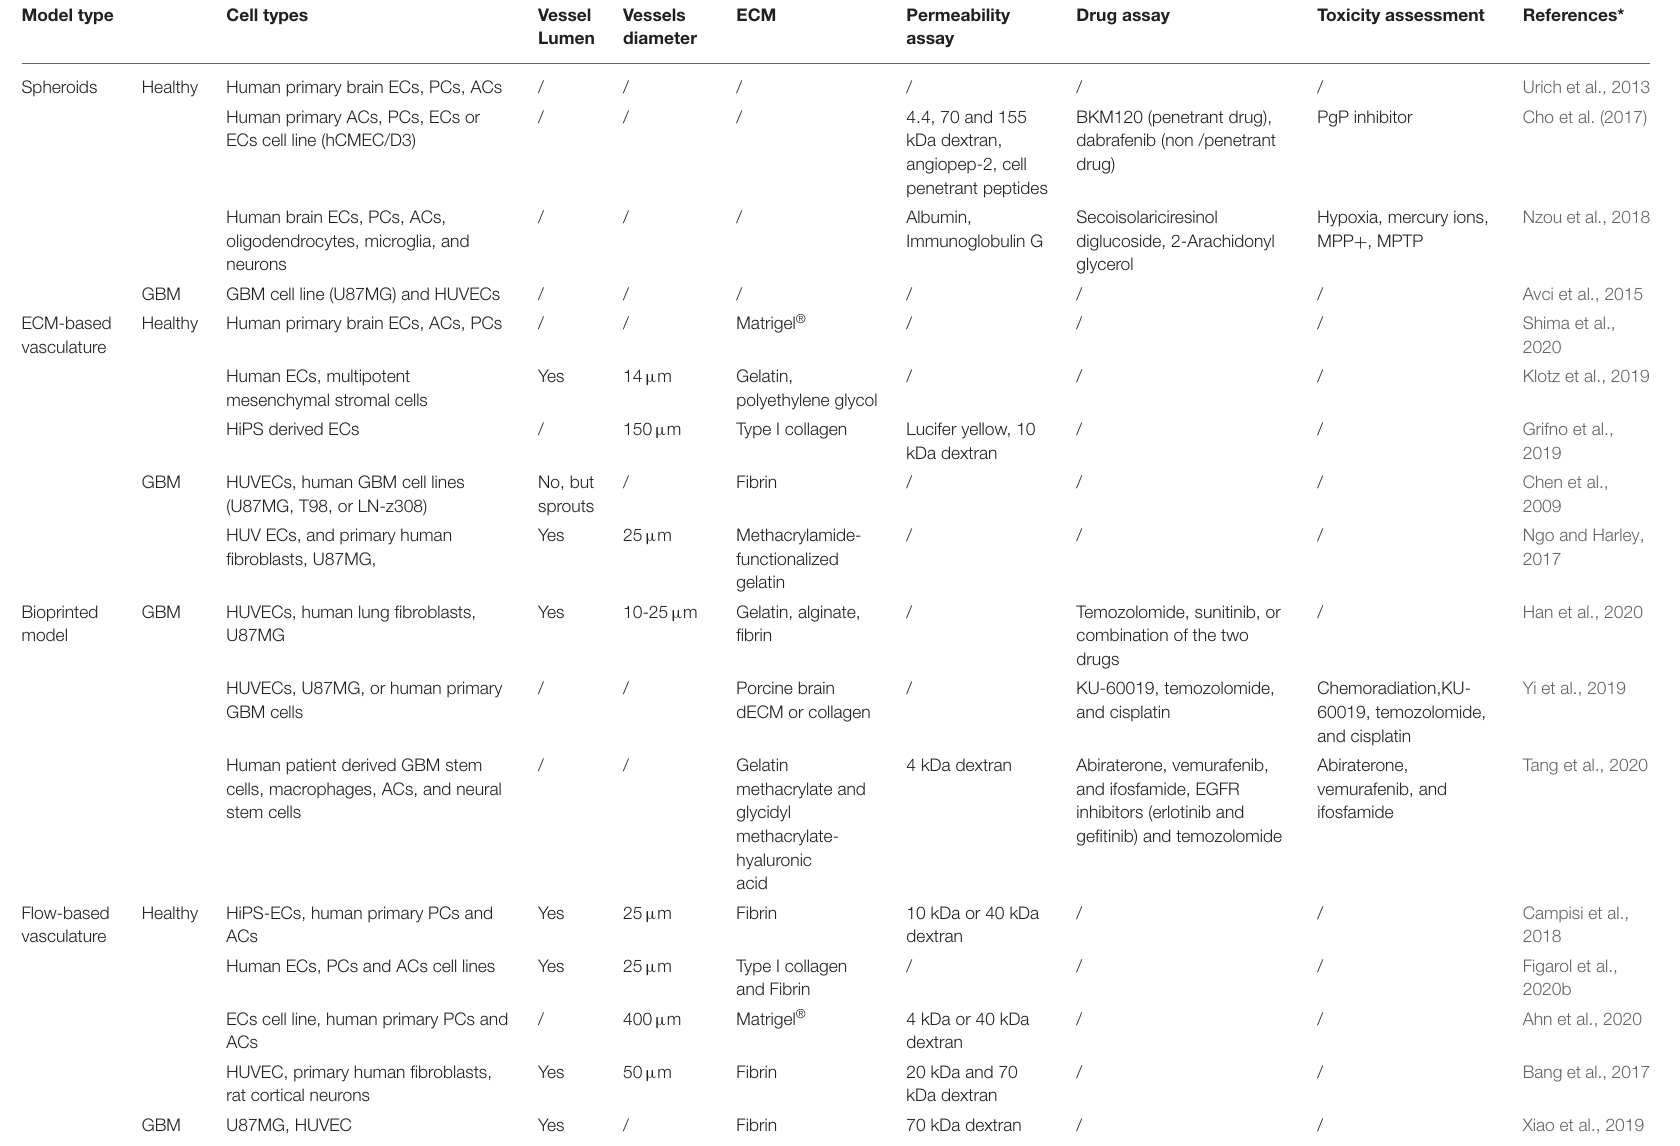
TABLE 1 | Summary of the key properties of the different healthy and tumor brain microvasculature models. Model